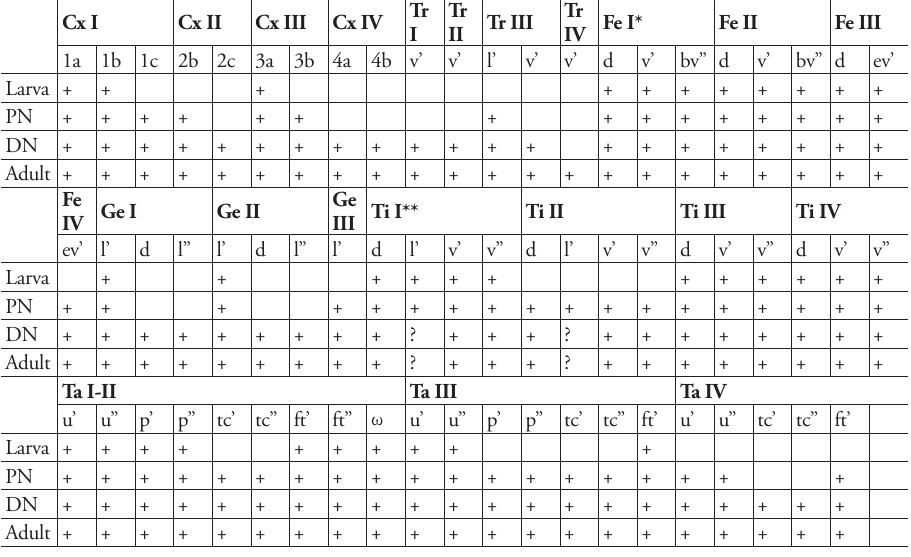
Table 1. Development of leg setae (after Seeman and Beard